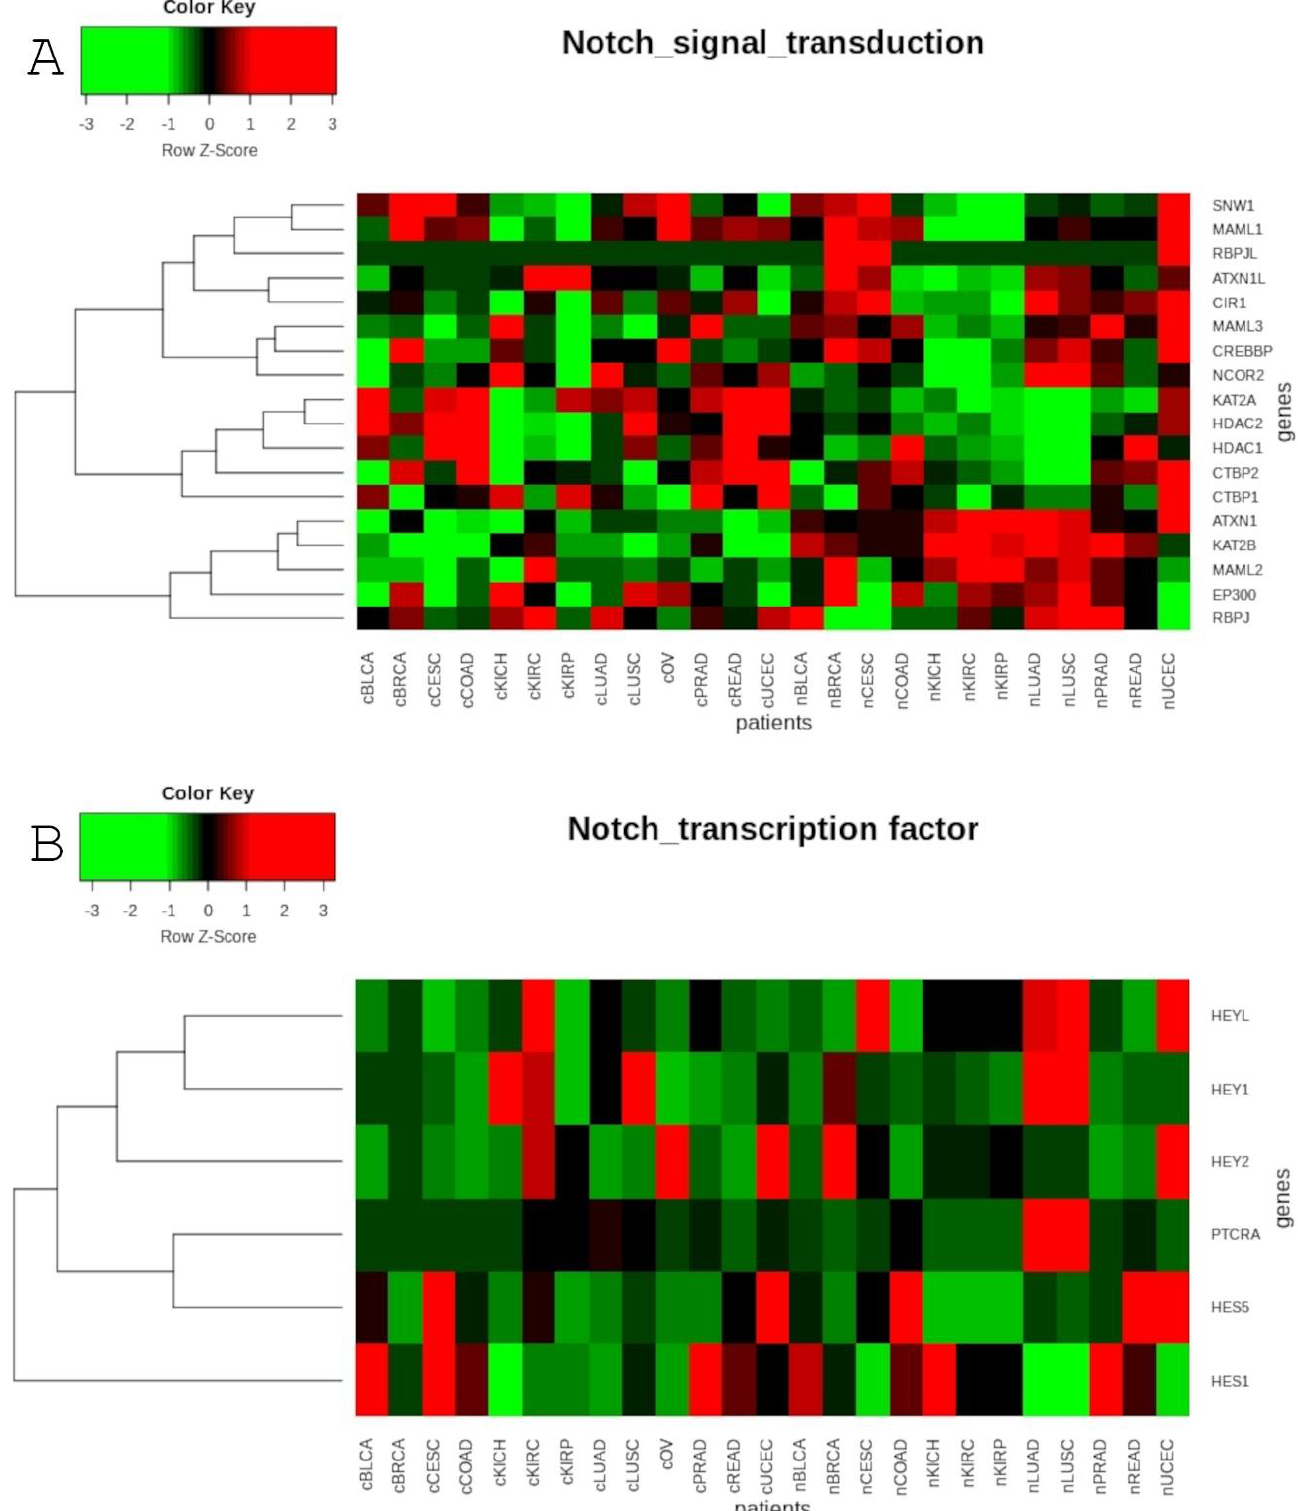
Figure 3. Heatmap reflecting the differential median expression of the Notch core components in the analyzed cancers and normal tissues: ( A ) signal transductors; ( B ) transcription factors.